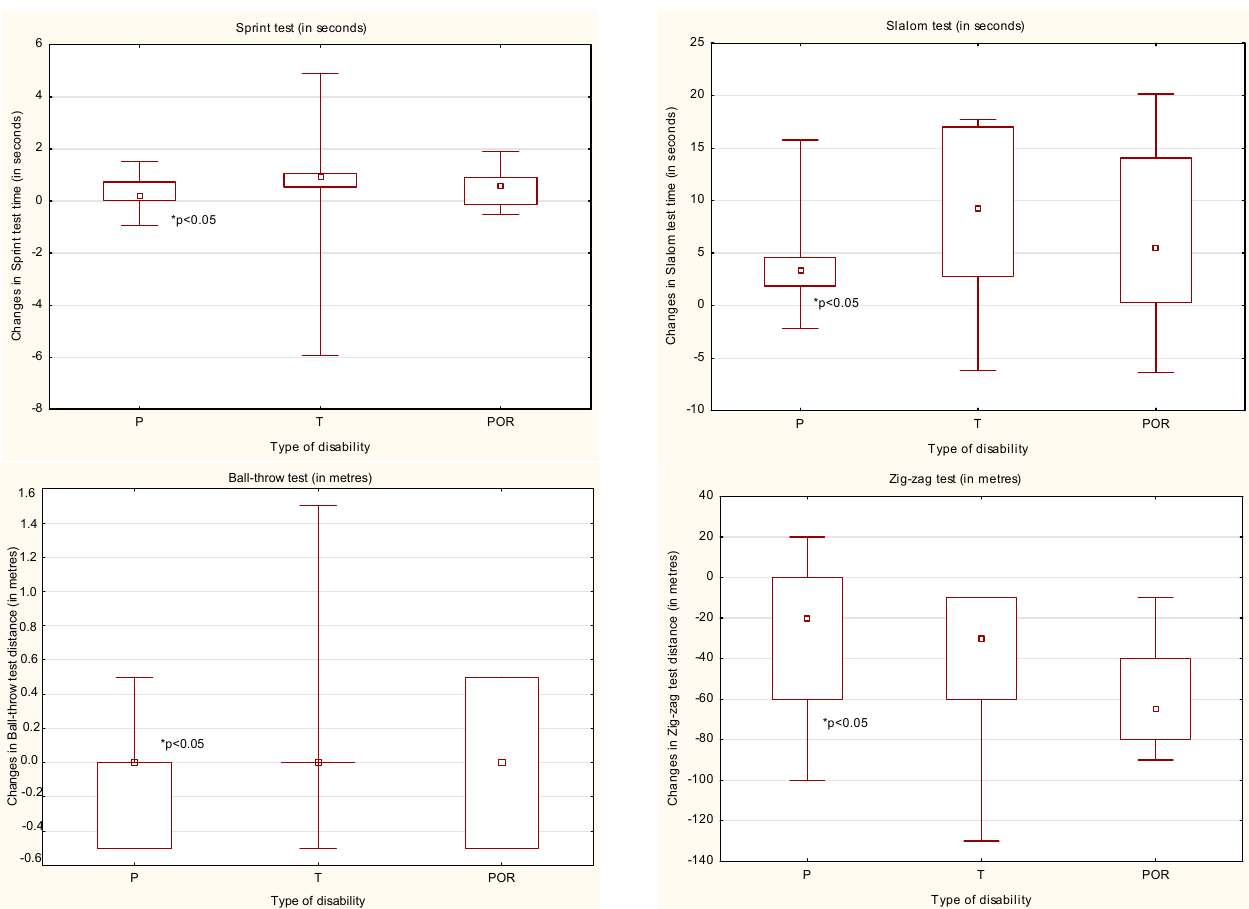
Figure 2. The changes in the results obtained before and after the ARC by the participants according to the type of injury. P—paraplegics; T—tetraplegics; POR—people with myelomeningocele core. After the ARC, people with spinal cord injury below Th-9 improved their results in all the tests with statistically significant difference of the results in sprint, slalom and zig-zag tests ( p < 0.05). People with spinal cord injury at the level of Th-9 and above also improved their results in sprint, slalom and zig-zag tests with statistically significant differences in all of the tests ( p < 0.05) (Tables 2–5, Figure